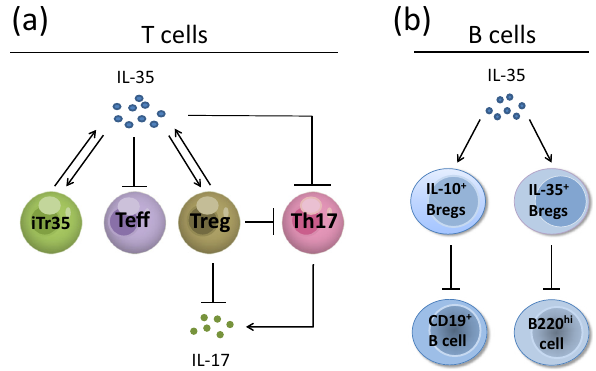
Figure 1: Biological functions of IL - 35. ( a ) IL - 35 regulates T cell - mediated immune responses. IL - 35 can induce iTr35 generation, and the resulting iTr35 cells produce additional IL - 35. IL - 35 suppresses Te ff proliferation. By upregulating the suppressive function of Tregs, IL - 35 can suppress Th17 cell di ff erentiation and IL - 17 secretion. ( b ) IL - 35 regulates B cell - mediated immune responses. IL - 35 induces IL - 10 + Bregs and IL - 35 + Bregs. Moreover, IL - 10 + Bregs inhibit the propagation of CD19 + B cells, and IL - 35 + Bregs suppress the expansion of B220 hi cells. iTr35: IL - 35 - induced regulatory T cells, Te ff : e ff ector T cell, Treg: regulatory T cell, ROR: retinoic acid receptor - related orphan receptor, IL - 10 + Breg: regulatory B cells secreting IL - 10, IL - 35 + Breg: regulatory B cells secreting IL -